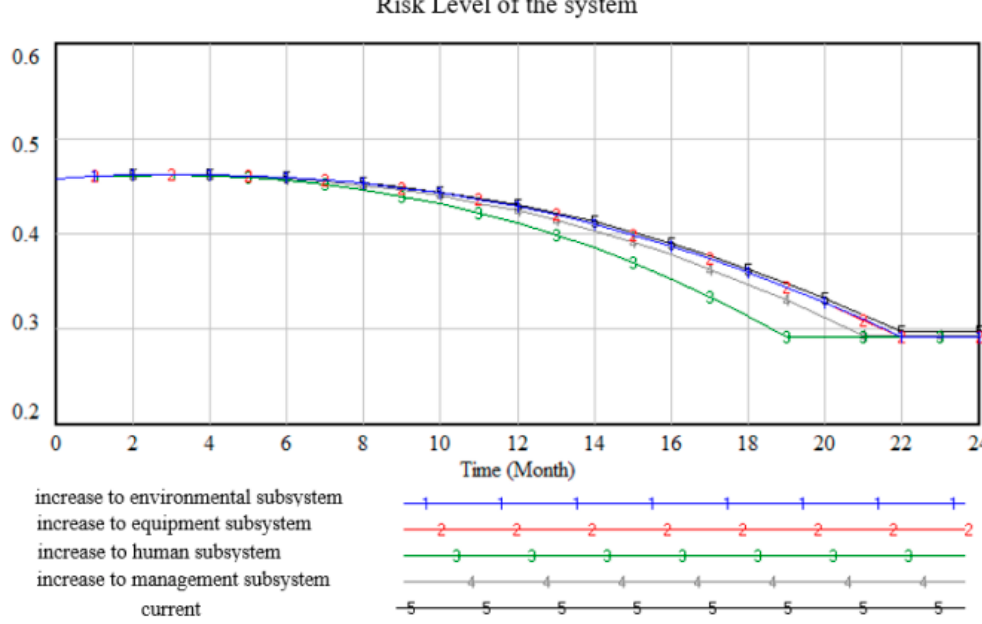
Figure 7. Contrast diagram of risk level under change of distribution ratio.